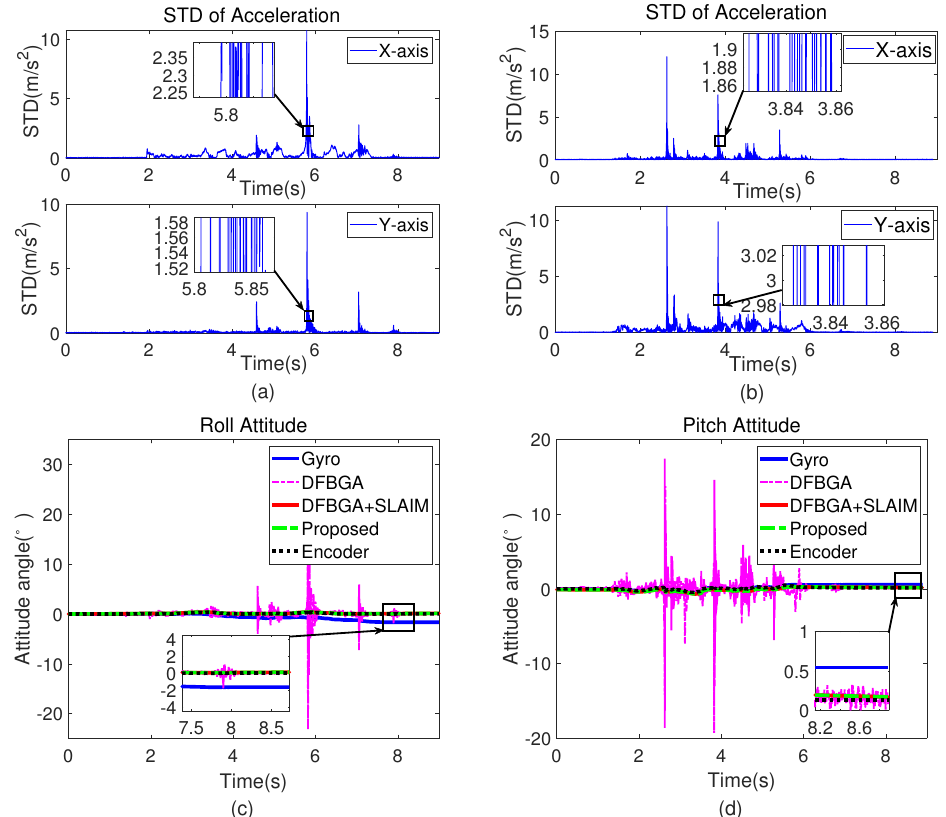
Figure 10. Comparison of static experimental results: ( a ) STD of acceleration corresponding to roll attitude. ( b ) STD of acceleration corresponding to pitch attitude. ( c ) Roll angular attitude (calculated by gyro, DFBGA, DFBGA and SLAIM, the proposed method, encoder) comparison. ( d ) Pitch angular attitude (calculated by gyro, DFBGA, DFBGA and SLAIM, the proposed method, encoder) comparison.